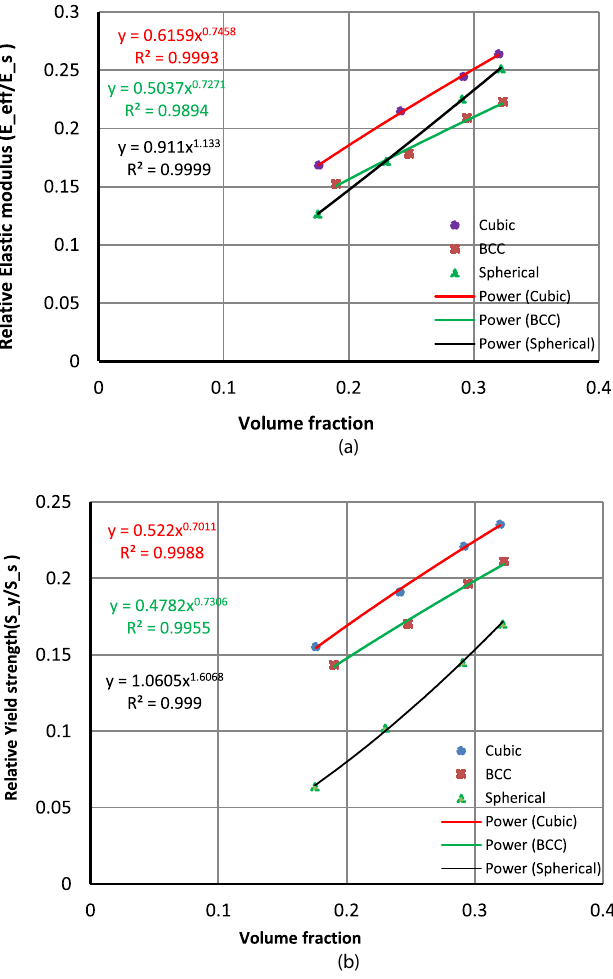
Fig. 10. Best- fi t power functions (a) relative effective elastic modulus-volume fractions curves of BCC, Cubic, and Spherical porous structures, (b) relative effective yield strength-volume fractions curves of BCC, Cubic, and Spherical porous